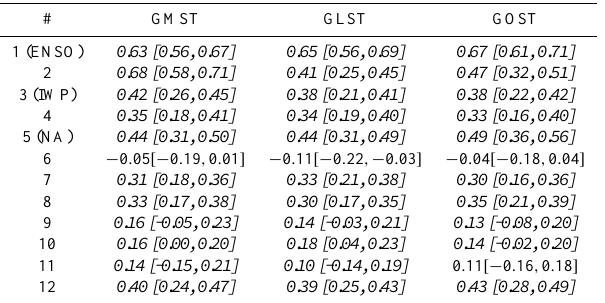
Table 3. Correlations between the mean time series of the commu- nities of the ESM-SST network and the indices of mean, land and ocean surface temperatures (all time series 1y low-pass filtered). The 95% confidence intervals are given in brackets and correlations significant at 5% are italic face.